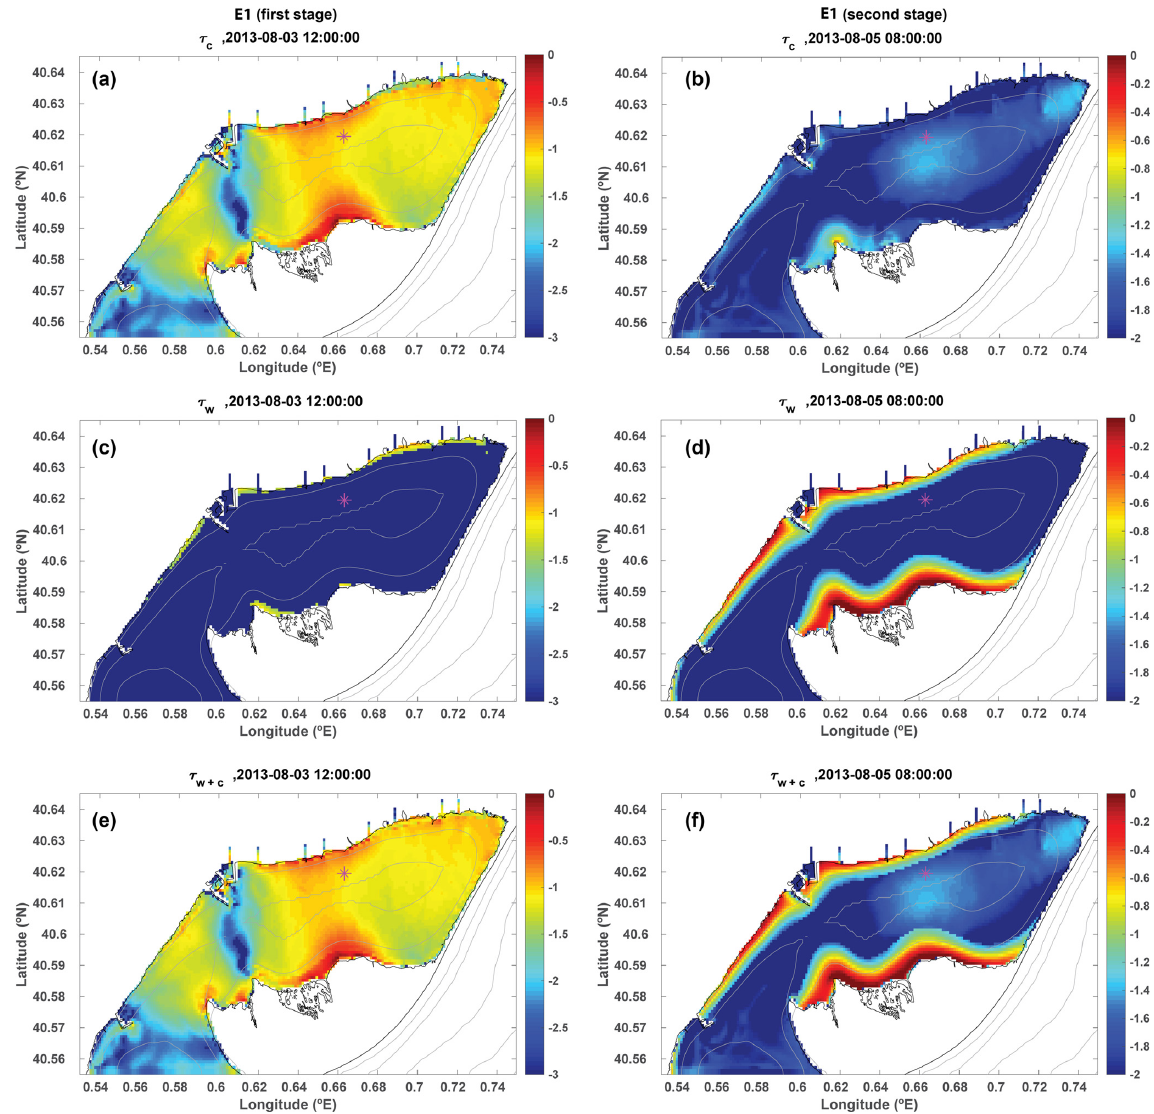
Figure 5. Current-induced bottom stress ( τ c ), wave-induced bottom stress ( τ w ), and combined wave–current bottom stress ( τ wc ) in Alfacs Bay during the first stage of the E1 episode (i.e. seiche; a, c, e ) and the second stage of the E1 episode (i.e. sea breeze; b, d, f ). The A2 station is shown in magenta. Isobaths are plotted using grey solid lines at 3m intervals from 3 to 12m. Note that for clarity, the bottom stresses are plotted in log 10 scale and the vertical range differs between both bottom stress